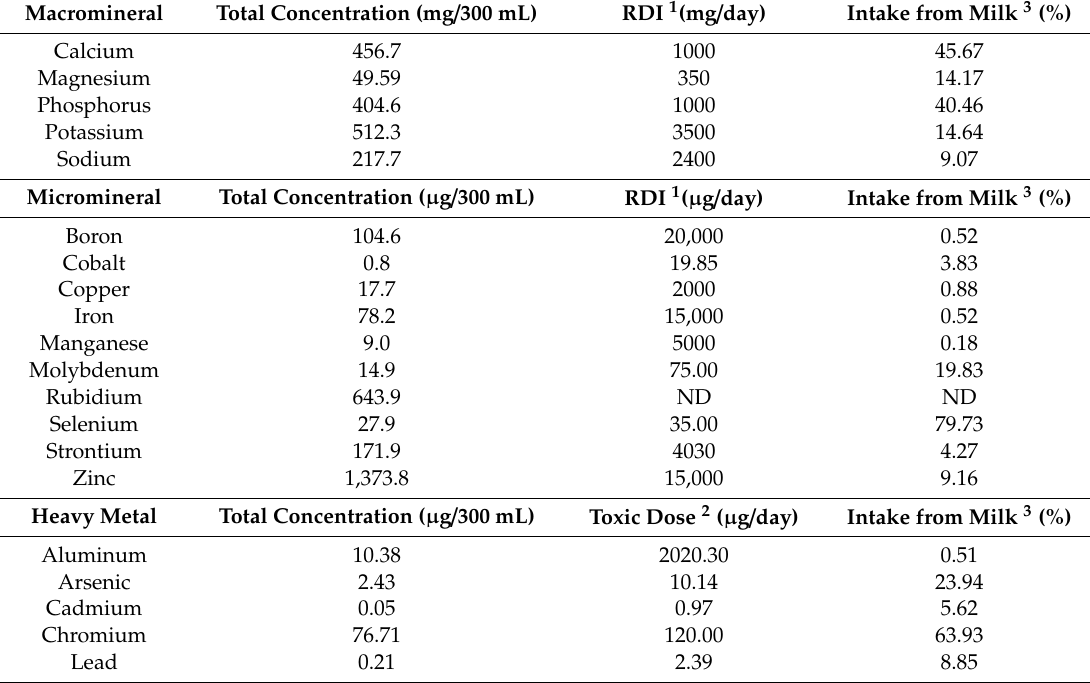
Table 4. Concentration and the percentage of daily intake of micro- and macrominerals as well as heavy metals in the raw milk of Alberta, Canada versus recommended daily intakes